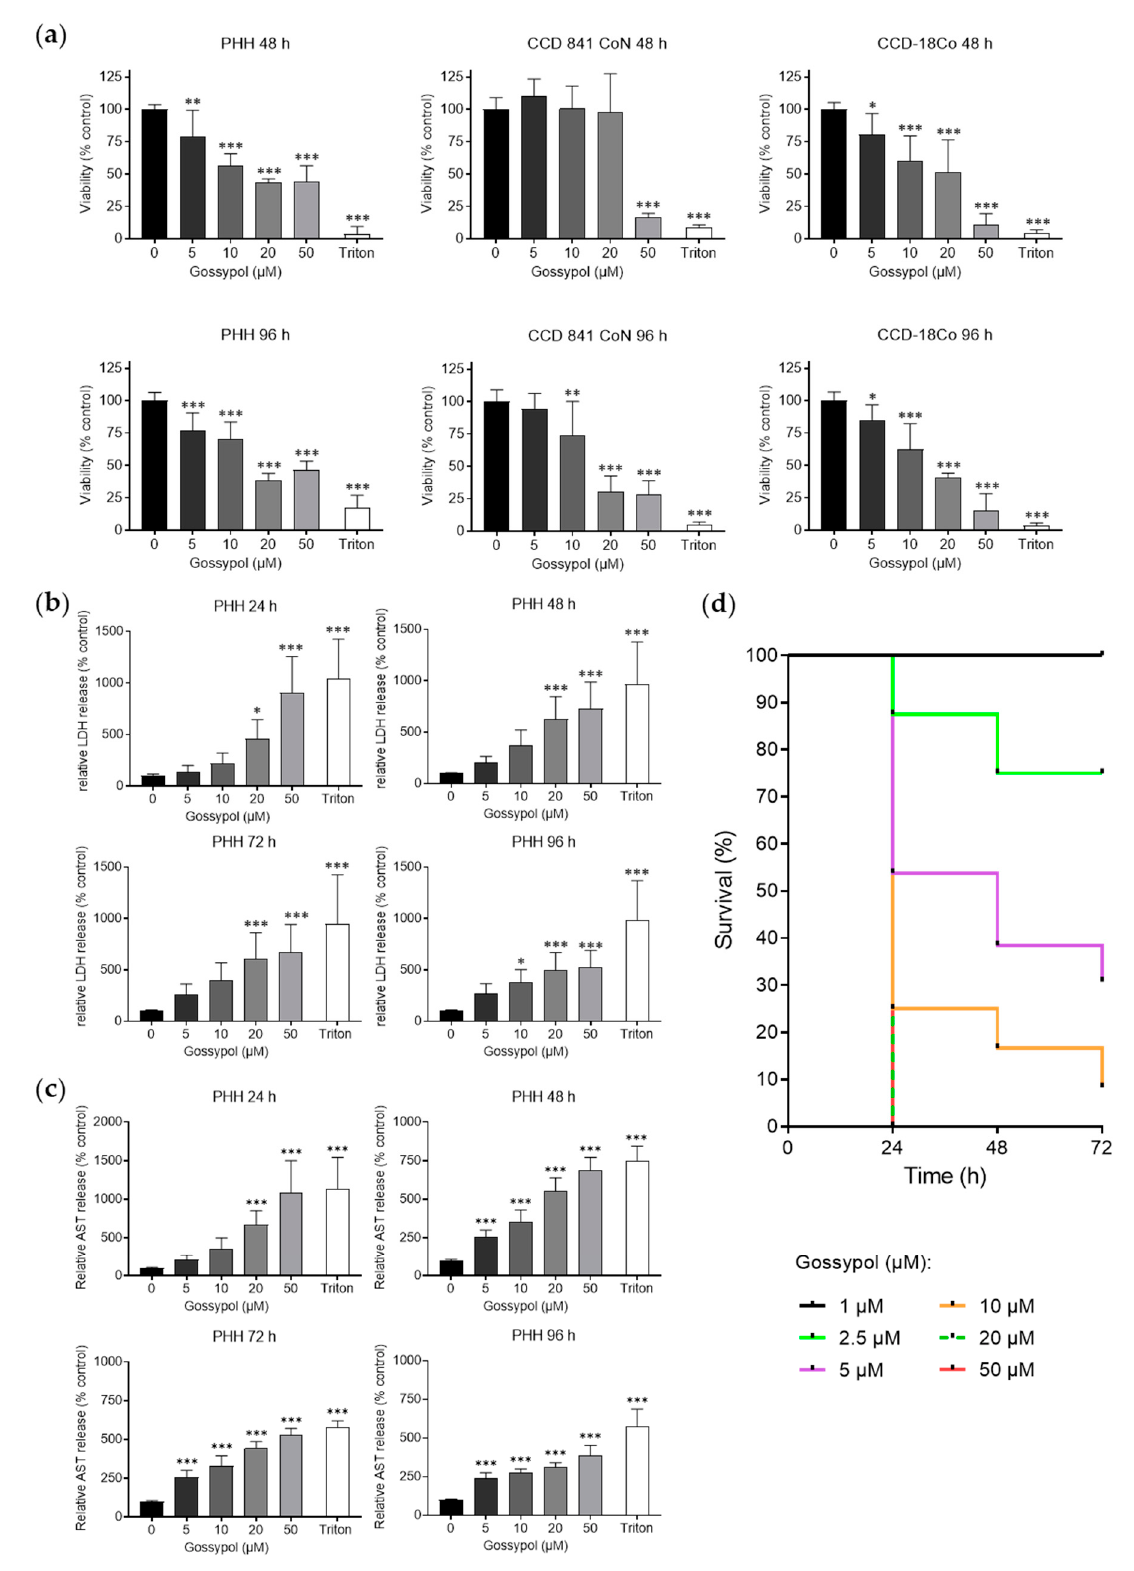
Figure 6. Gossypol induced toxicity. ( a ) Cell viability investigated via SRB assay with non-malignant PHHs from three different donors and epithelial non-malignant colon cells (CCD-18Co, CCD 841 CoN). Cells were treated for 48 h and 96 h with increasing concentrations of gossypol (5 µM, 10 µM, 20 µM, 50 µM), with culture medium as negative and Triton X-100 as positive controls. Values rep- resent means ± SD of three independent experiments, each performed in triplicate. For statistical